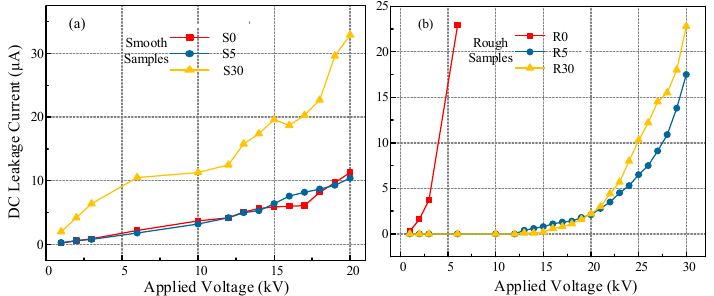
Figure 10. DC leakage current curves of samples under different solution soaking. ( a ) Smooth samples soak in deionized water; ( b ) Rough samples soak in deionized water.